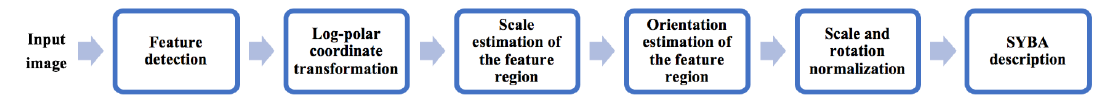
Figure 2. SR-SYBA block diagram.